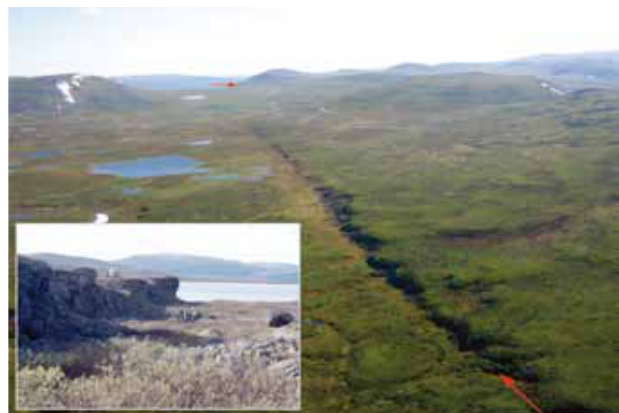
Figure 2. Helicopter view of the southwestern part of the Pärvie PG fault (see Fig. 1 for location). The red arrows show the trace of the fault scarp. The insert shows the fault scarp from the ground surface, about 85 km to the northeast of the location of the large photo, including a helicopter for